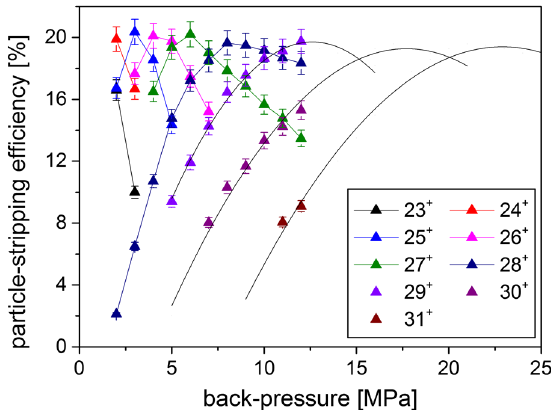
FIG. 6. Stripping efficiency for different uranium charge states in a H 2 -gas cell; the maximum available back pressure was limited for 12 MPa. An optimistic trend approximation is included for higher back pressure